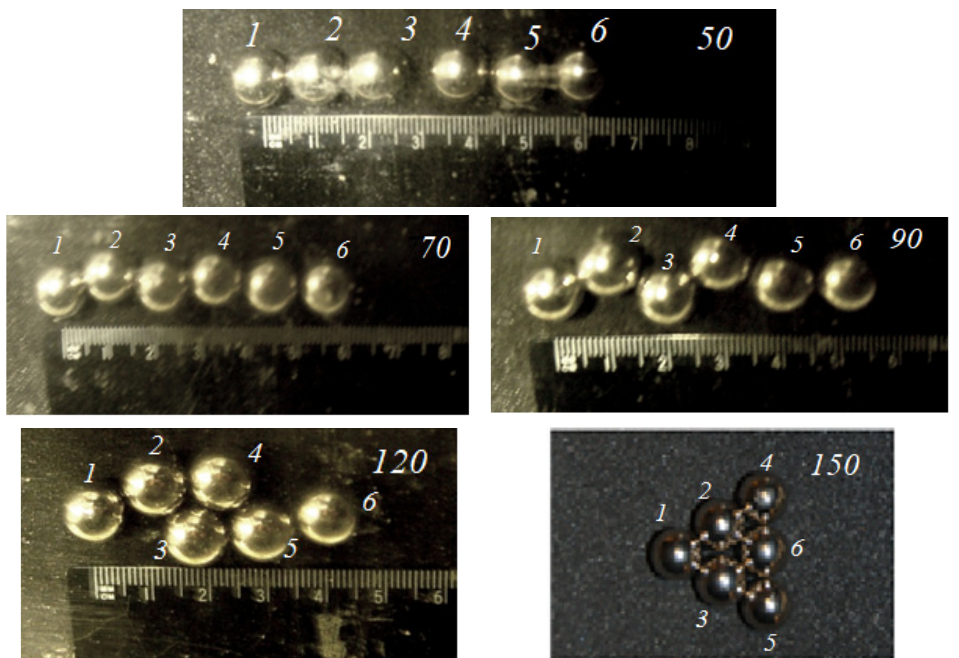
Figure 3. Movement along the line of balls (the initial distance between the centers in the line was 15 mm). The number of cycles is reported in the upper right corner.